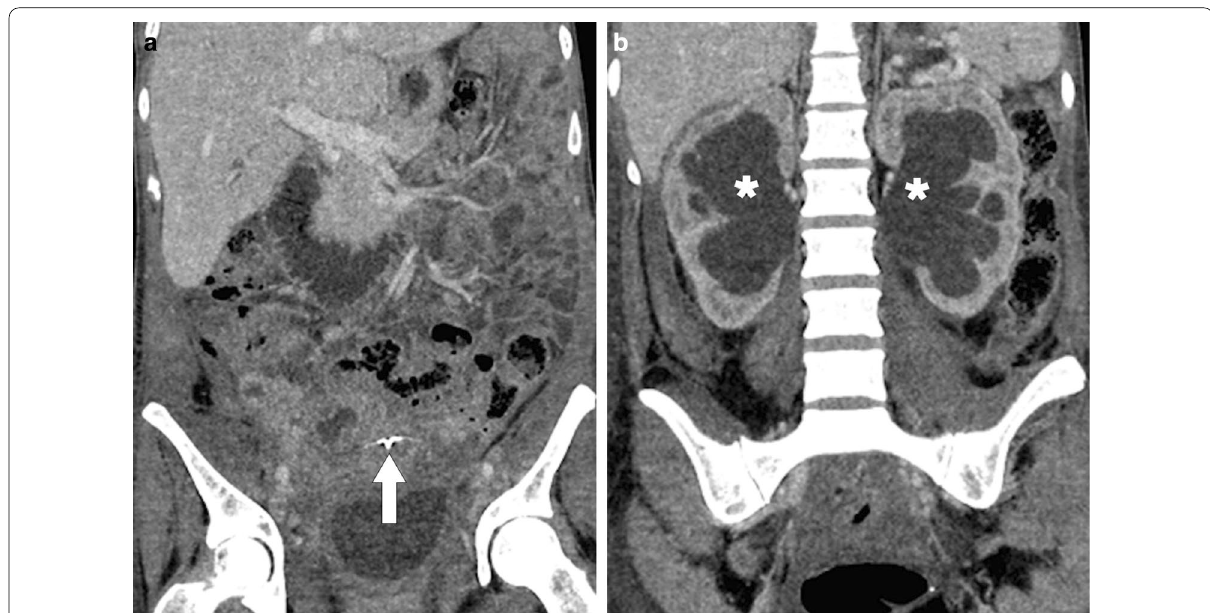
Fig. 25 Pelvic actinomycosis. A 32-year-old woman with intrauterine contraceptive device now presenting with diffuse abdominal pain and serous vaginal discharge. a Coronally reformatted post contrast CT image shows the IUD (arrow). Pelvic fat planes are obliterated. b Coronally reformatted postcontrast CT image reveals bilateral severe hydroureteronephrosis (asterisks). Endometrial biopsy showed actinomycotic bacteria on both Gram and silver